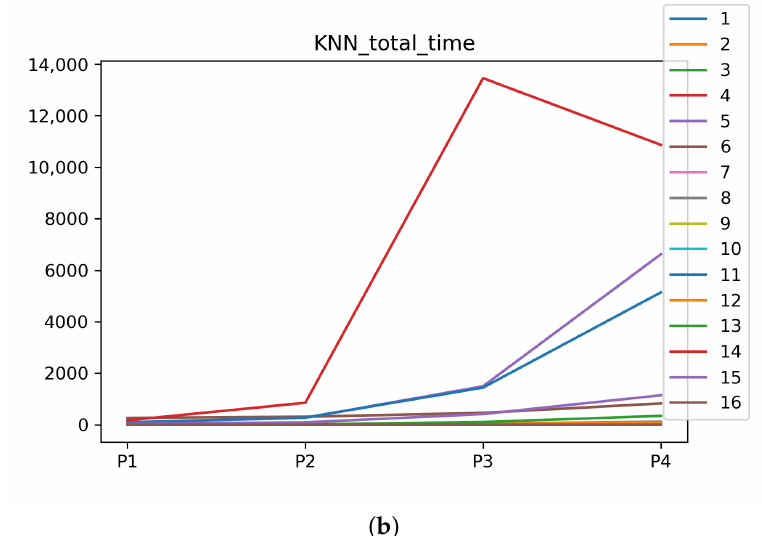
Figure A3. Behavior of RHOASo: time complexity. Each line represents a dataset. ( a ) Time complexity for DT. ( b ) Time complexity for KNN.